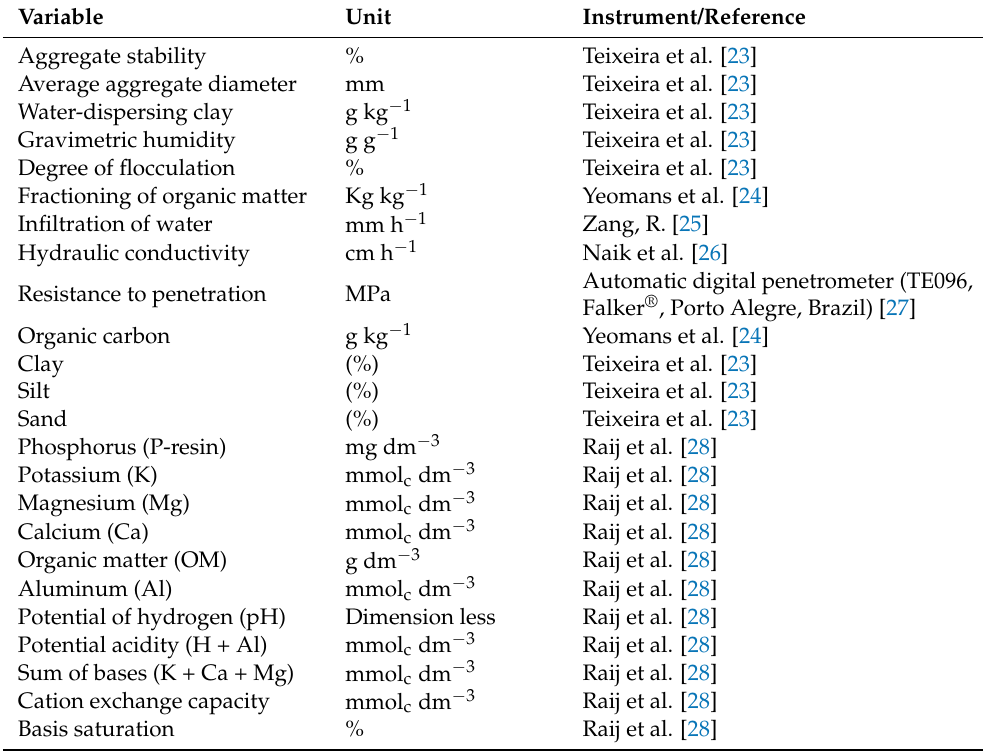
Table 2. Physical and chemical indicators of the recuperative potential of integrative